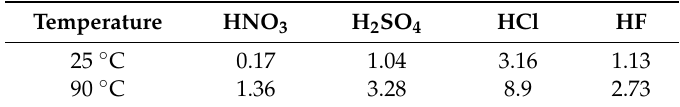
Table 2. The leaching efficiency of gallium (%) with four acid with concentrations 10 M at liquid-solid ratio of 50 (mL/g) at 25 ◦ C and 90 ◦ C for 4 h respectively.